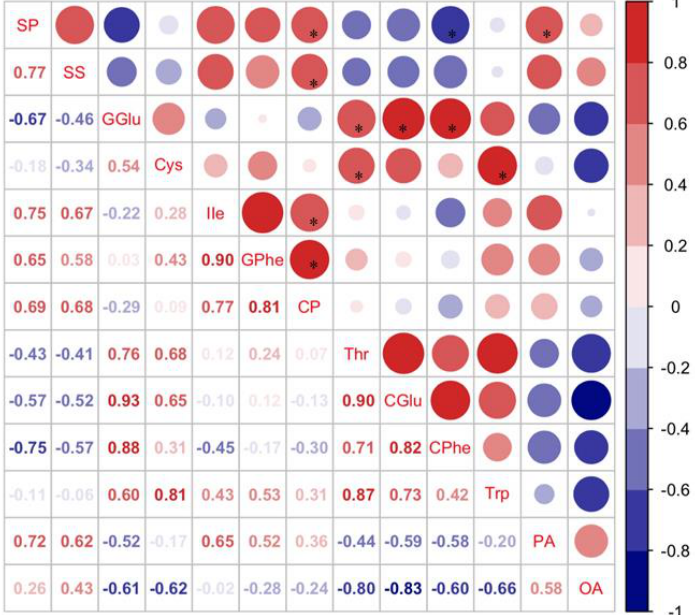
Figure 4. Pearson correlation between nutrients in soybean and nutrient content of C. bilineata tsing-